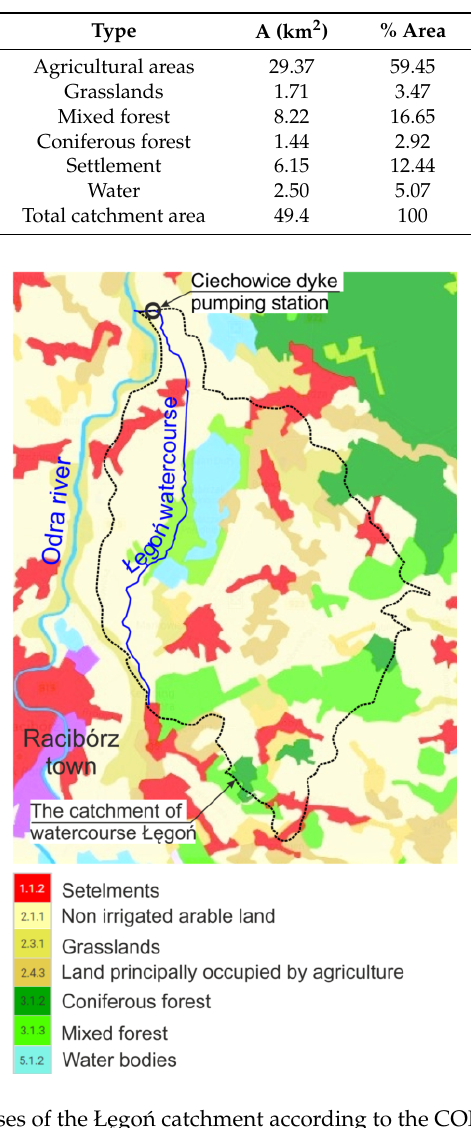
Figure 2. Land use classes of the Ł˛ego´n catchment according to the CORINE Land Cover